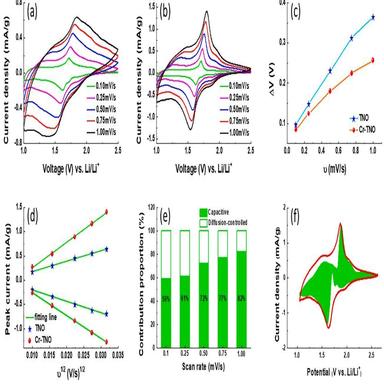
Electrochemical characterization of as-prepared TNO. (a, b) CV profiles of (a) pristine TNO and (b) Cr-TNO, recorded at various scan rates. (c) ΔV-υ plot of the pristine and doped TNO. (d) Linear relationships between the anodic and cathodic peak current densities and the square root of the scan rate (υ1/2); (e) Contributions of the capacitive- and diffusion-controlled capacities for Cr-TNO at various scan rates and (f) contribution of the diffusion-controlled capacity (green shaded region) in the CV trace